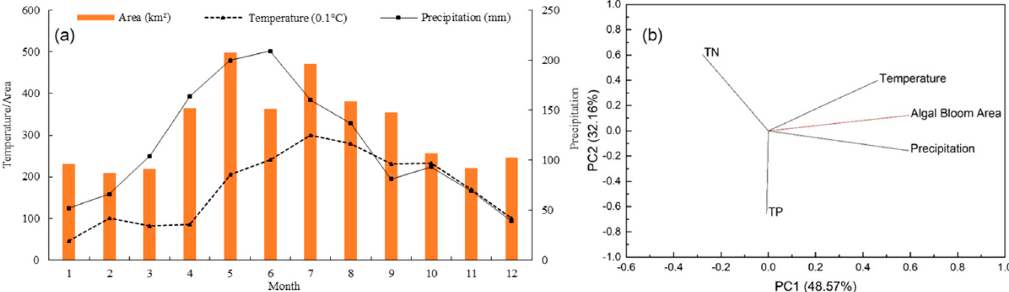
Figure 18. ( a ) Relationships between the average monthly precipitation, average monthly water temperature and algal bloom area from 2001–2017. ( b ) PCA ordination diagram of monthly algal blooms in Dongting Lake.